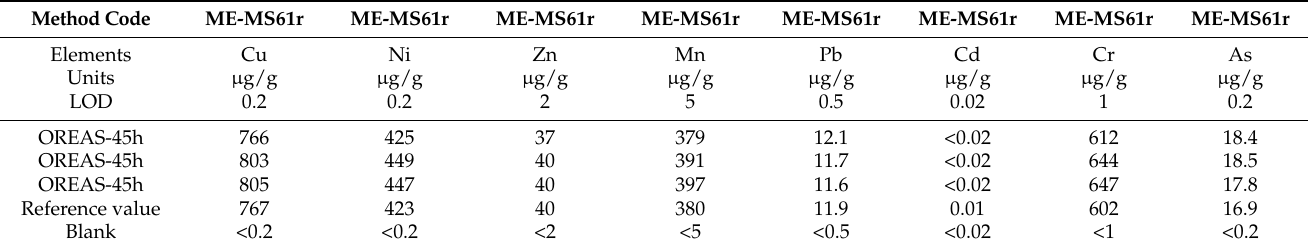
Table 1. The limits of detection (LOD) and validation data for target